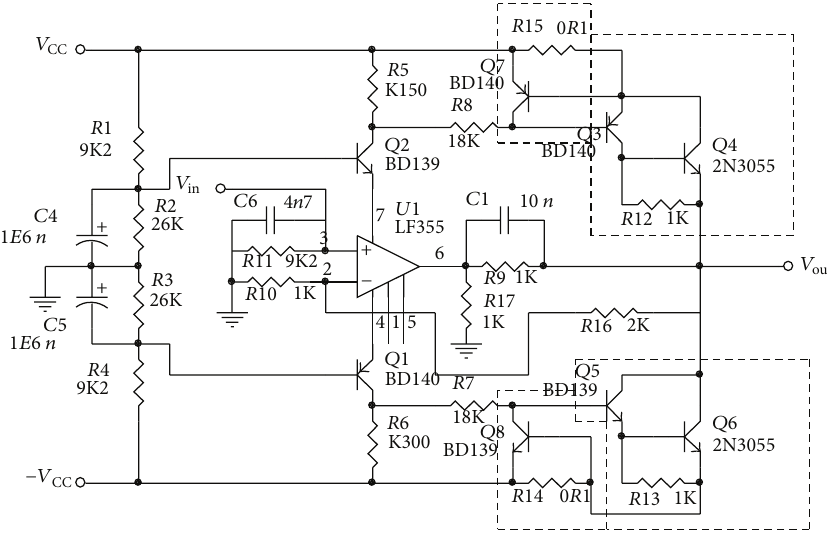
Figure 2: Electrical diagram of the power amplifier.